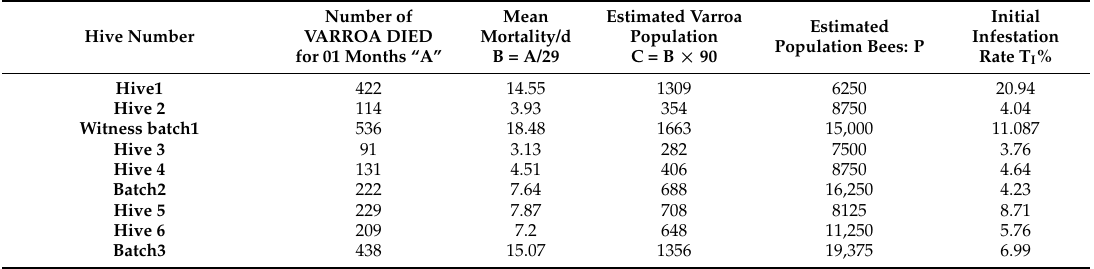
Table 1. Estimation of the initial infestation rate (before treatment) in the different hives and lots.